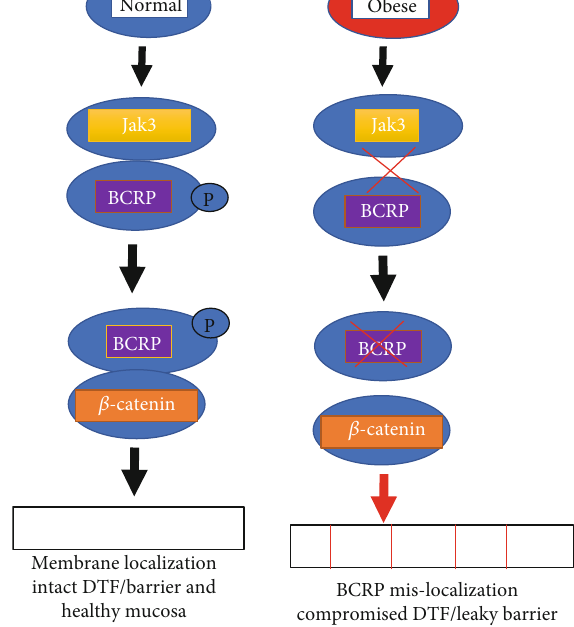
Figure 8: Proposed models for BCRP phosphorylation mediated mucosal barrier function and predisposition to obesity